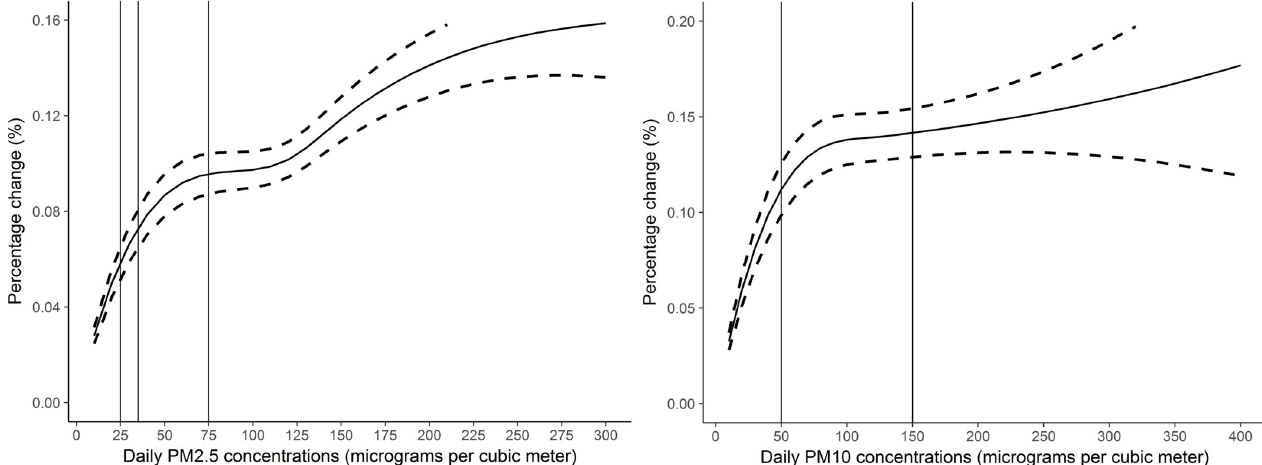
Fig 2. National-average concentration-response curves of 3-day moving average (lag 0–2) concentrations of PM 2.5 and PM 10 and hospital admissions for pneumonia in 184 cities in China, 2014–2017. Note, y-axes of the two graphs are scaled differently. The solid line represents relative changes and the dashed lines represent the 95% CIs. The vertical lines represent the air quality guidelines or standards for 24-hour average concentrations of PM 2.5 and PM 10 . PM 2.5 : 25 μ g/m 3 is the World Health Organization (WHO) air quality guideline for daily PM 2.5 concentrations, 35 μ g/m 3 is the Chinese Grade I standard for daily PM 2.5 concentrations, and 75 μ g/m 3 is the Chinese Grade II standard; PM 10 : 50 μ g/m 3 is both the WHO air quality guideline and Chinese Grade I standard for daily PM 10 concentrations, and 150 μ g/m 3 is the Chinese Grade II standard for daily PM 10 concentrations. PM 2.5 , particulate matter � 2.5 μ m in aerodynamic diameter; PM 10 , particulate matter � 10 μ m in aerodynamic diameter.